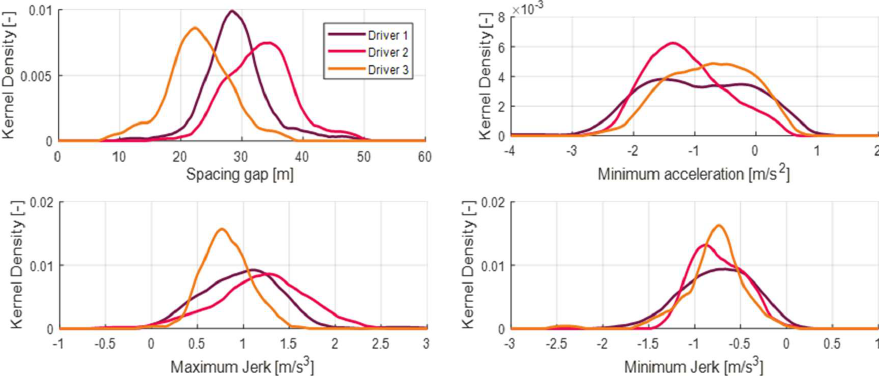
Figure 3. Kernel density estimation (KDE) of driver features; spacing gap, maximum jerk, and Figure 3. minimum jerk.